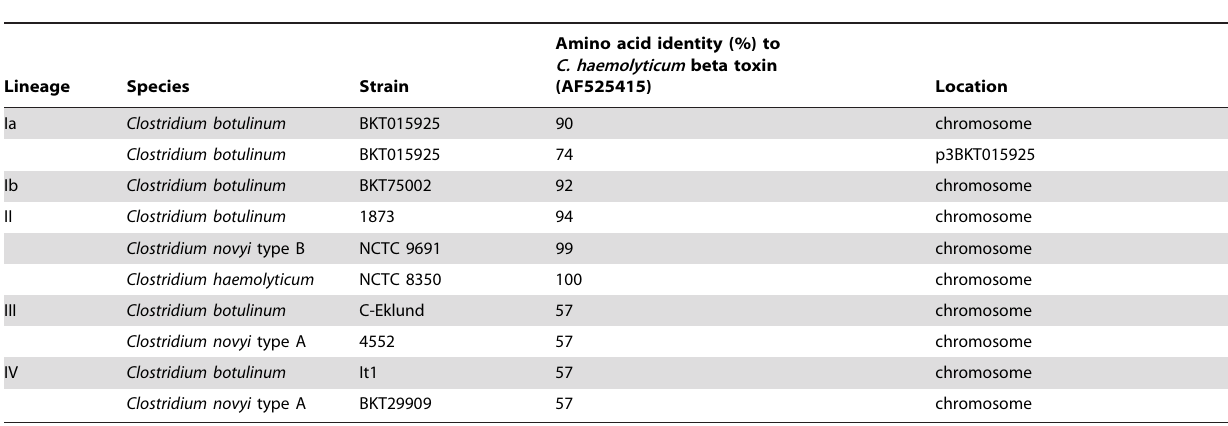
Table 2. Comparison of phospholipase C encoding genes in C. novyi sensu lato genomes.